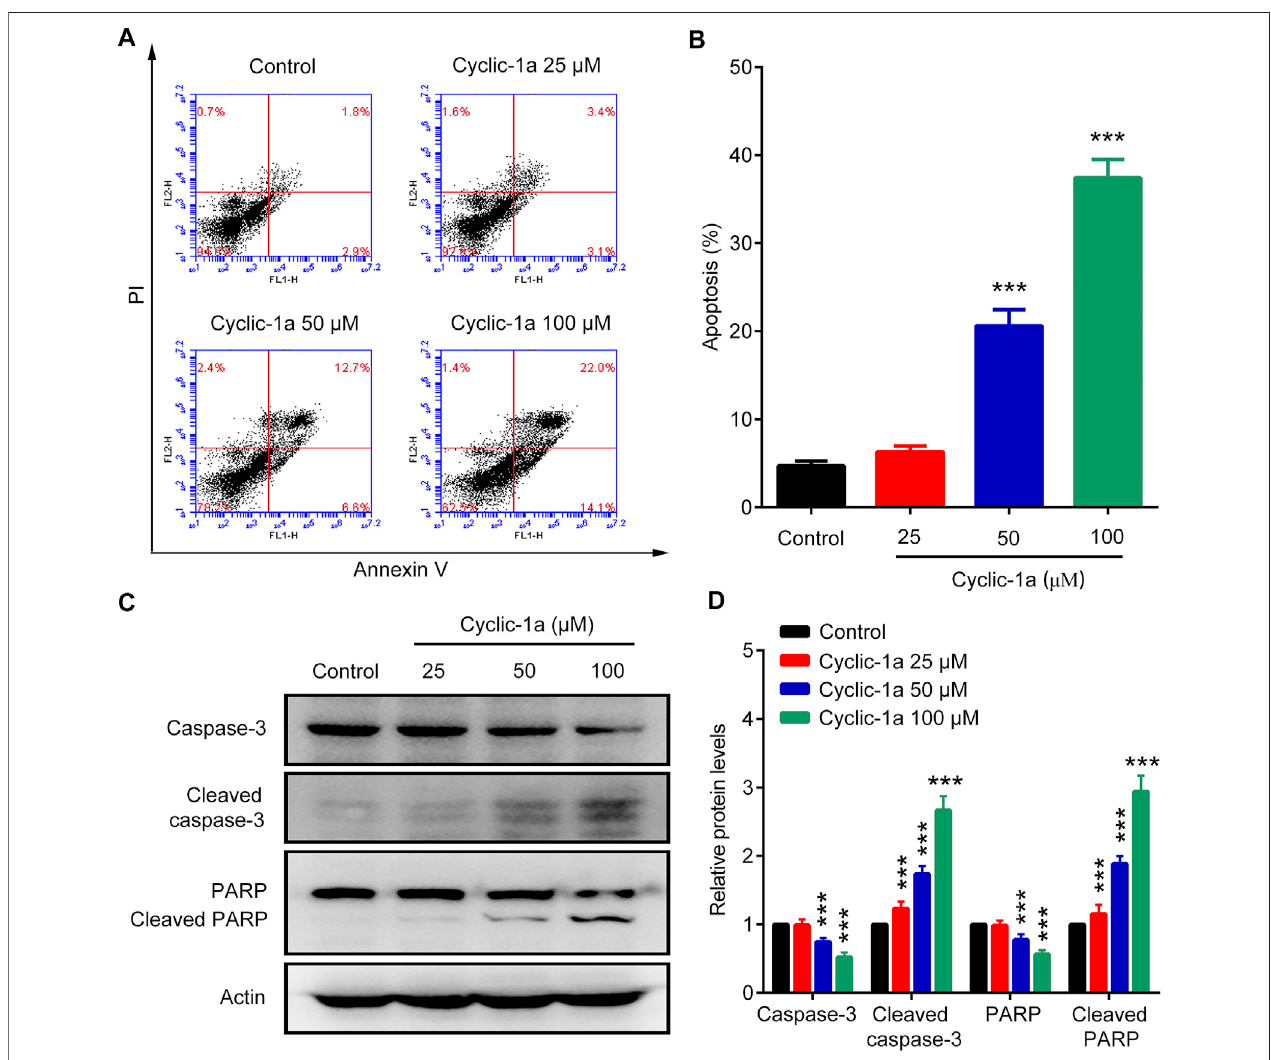
FIGURE4| Effectofcyclic-1aonapoptosisofMCF-7/DOXcells. (A – B) Flowcytometryanalysis. (C – D) Westernblotanalysis.Dataarerepresentedasmean ± SD, n (cid:1) 3. *** p < 0.001 vs control group.